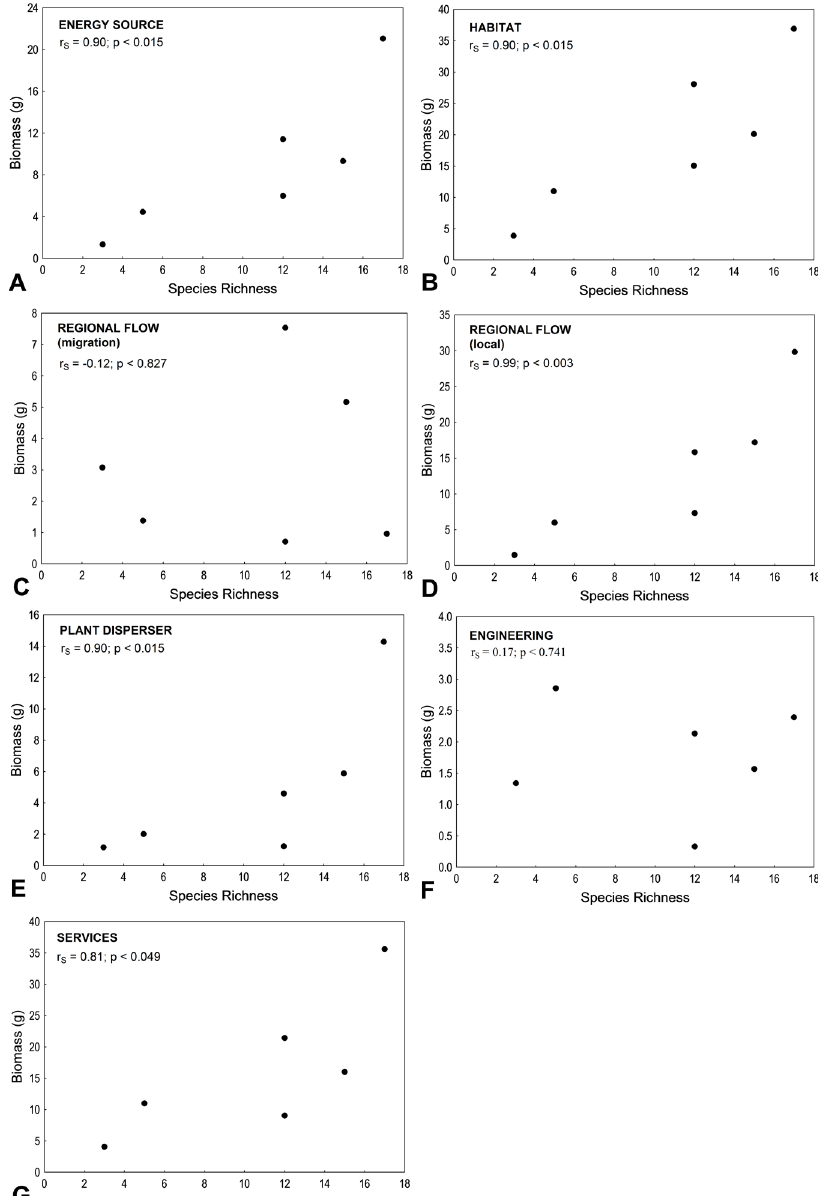
FIGURE 6 | Correlations between species richness and the intensity of ecosystem functions performed by fish populations. The significance of correlations was tested through Spearman's non-parametric correlation. Ecosystem functions: A. Energy Source; B. Habitat; C. Regional Flow (migration); D. Regional Flow (local); E. Plant Disperser; F. Engineering; G.